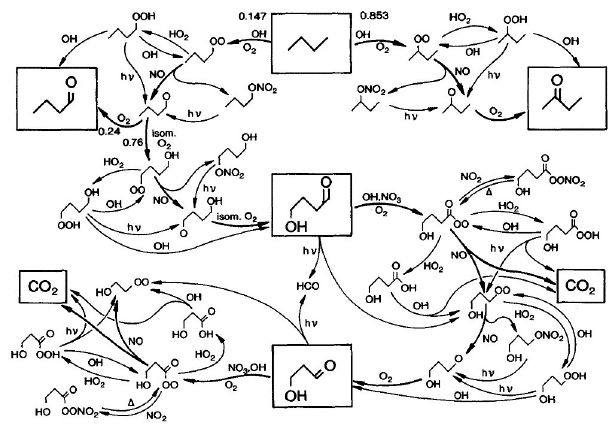
Figure 7. Oxidation mechanism of butane in the Master Chemical Mechanism (Jenkin et al., 1997) (under